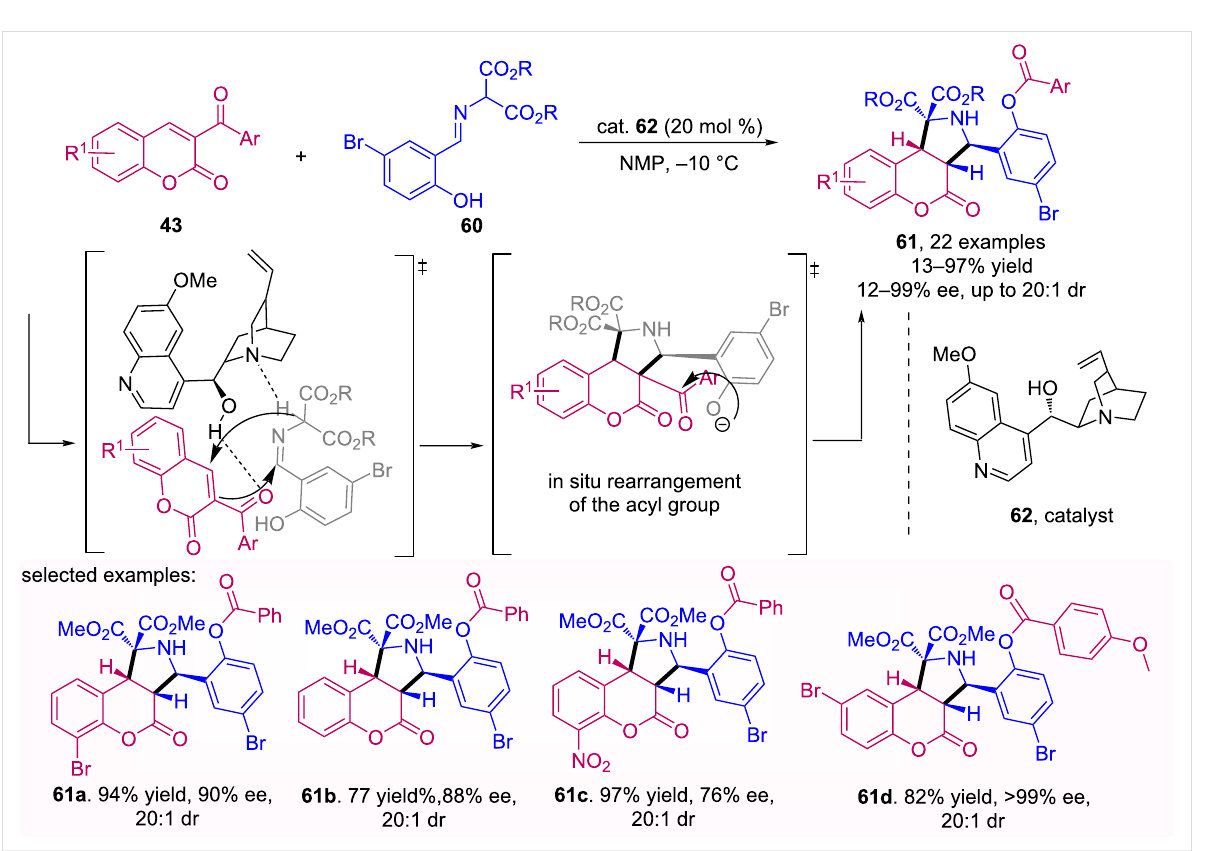
Scheme 19: Asymmetric [3 + 2] cycloaddition of coumarins 43 to azomethine ylides 60 organocatalyzed by quinidine 62